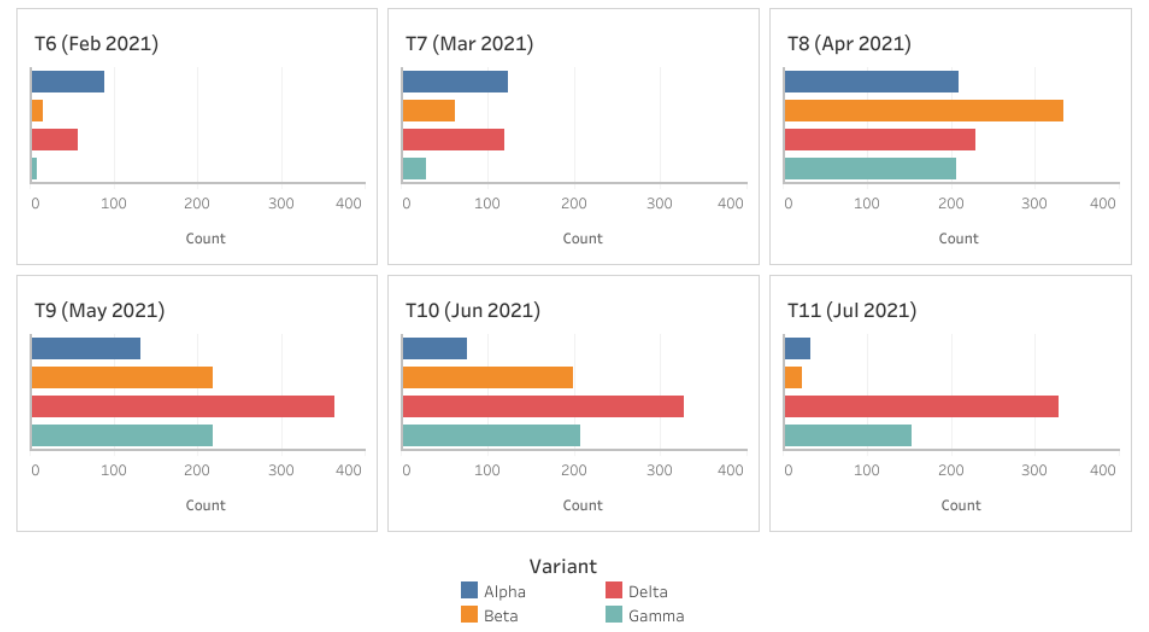
Figure 3. Occurrence of the four variants: Alpha, Beta, Delta and Gamma in periods T6 to T11. The variants are color coded as shown by the legend.